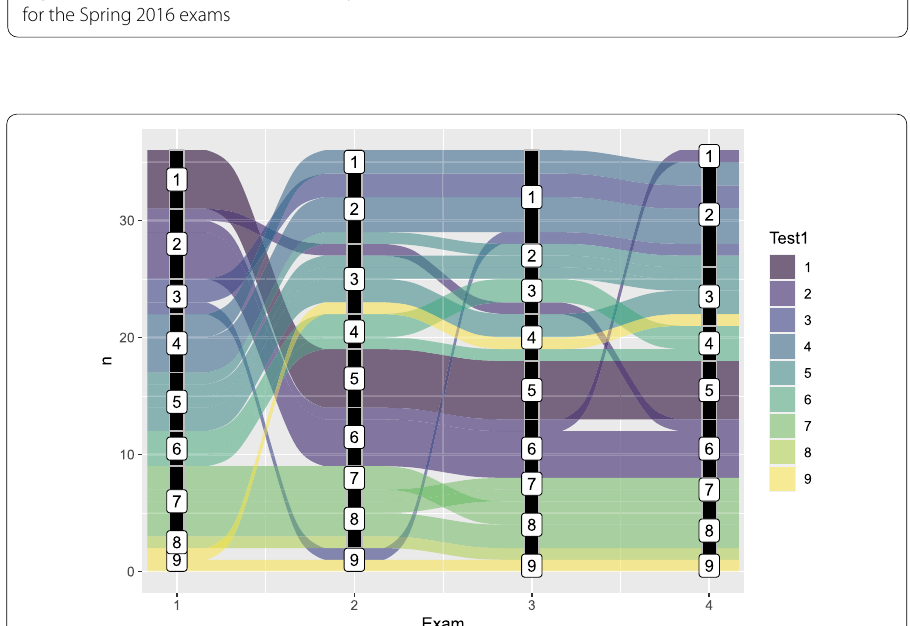
Fig. 19 Spring 2016 CONCOR block membership by exam. Traces are colored by students’ exam 1 block